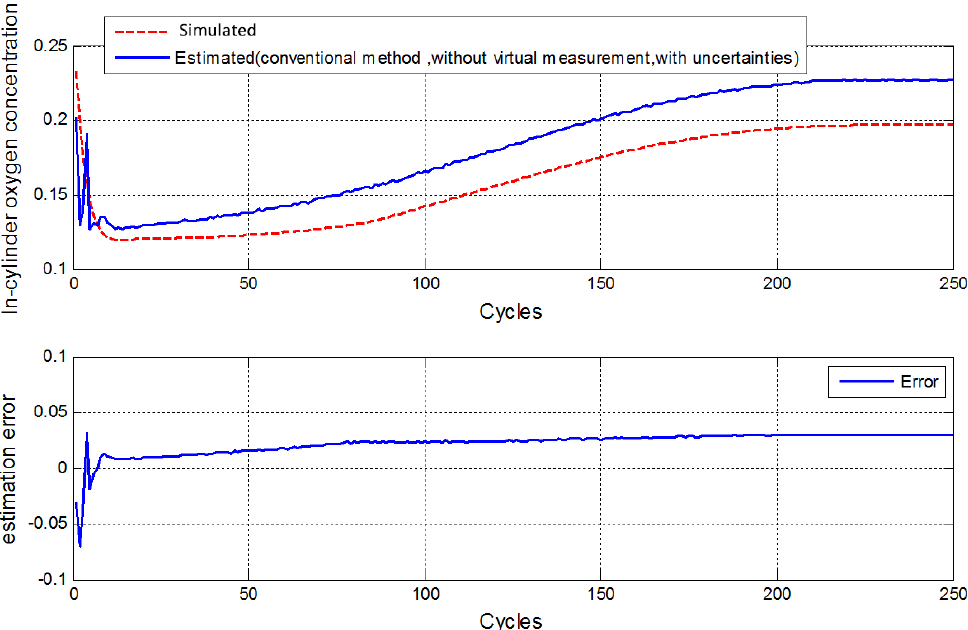
Figure 11. Performance of the dynamical model based method (with uncertainties).